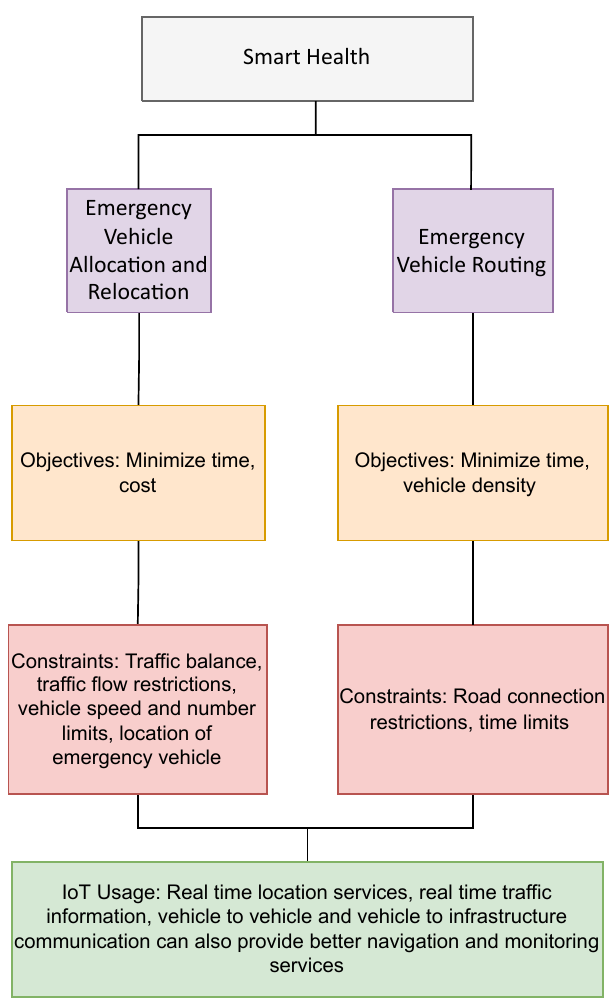
Figure 4. Optimization applications in Smart